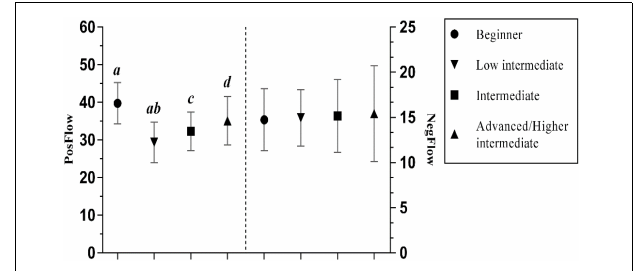
FIGURE 5 | The effects of FL mastery on PosFlow and NegFlow (Means and Significant Differences).